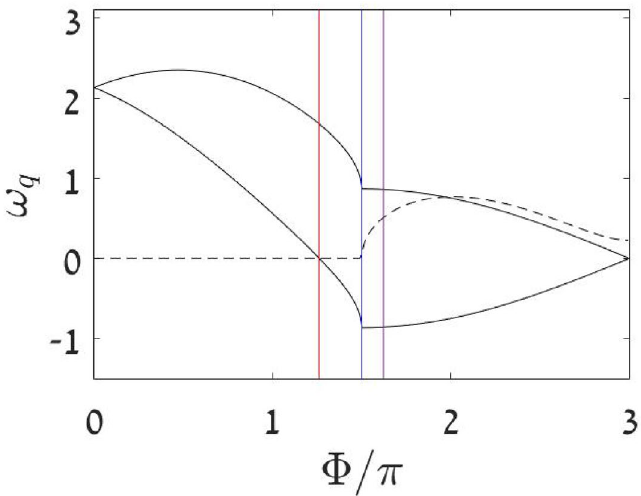
0 condensate. The vertical lines from =